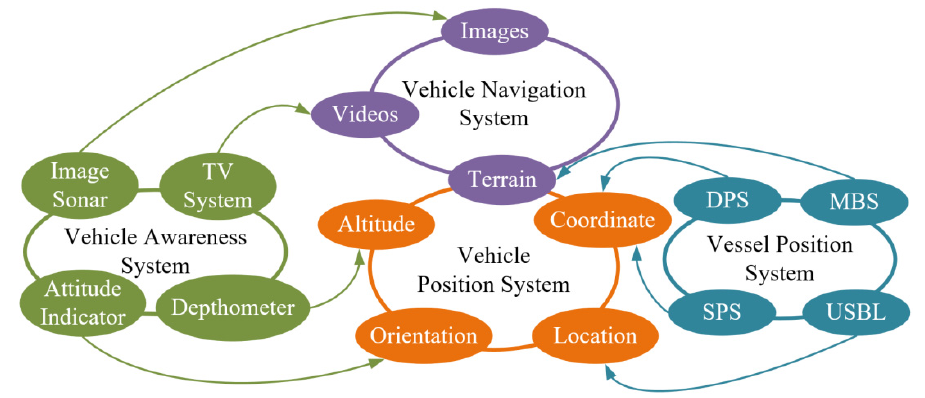
Figure 7. Awareness system and Positioning and navigation system.